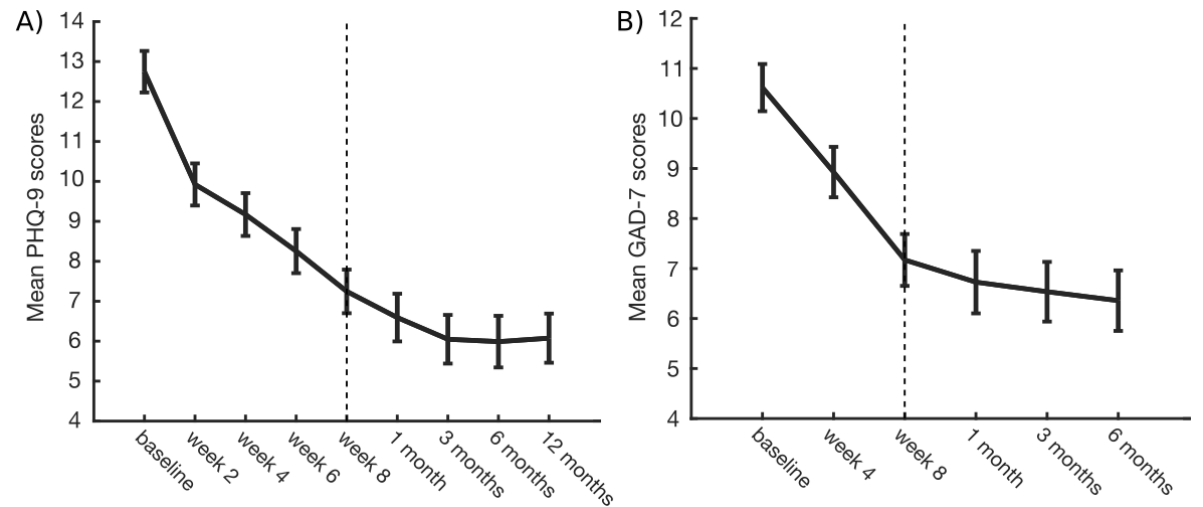
Figure 1. Estimated marginal means for PHQ-9 (A) and GAD-7 (B) scores across all available timepoints. The dotted line indicates the last week of the 8-week intervention. Error bars represent standard error of the mean. PHQ-9: Patient Health Questionnaire (9-item version); GAD-7: Generalized Anxiety Disorder (7-item